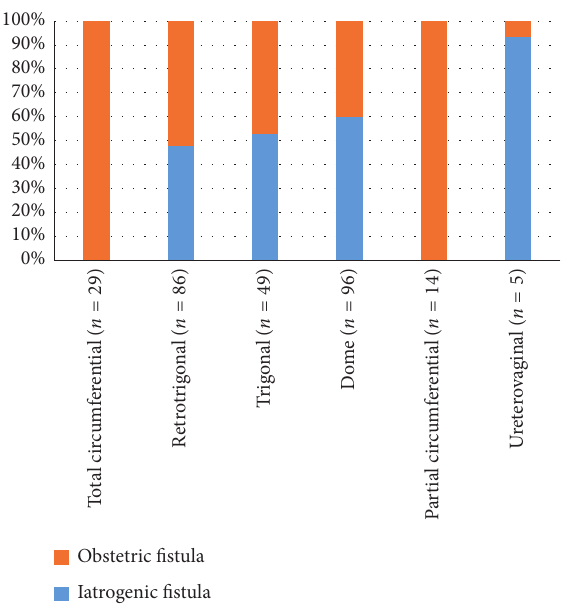
Figure 3: Seat of the vaginal fistula. Table 2: The Goh classification of